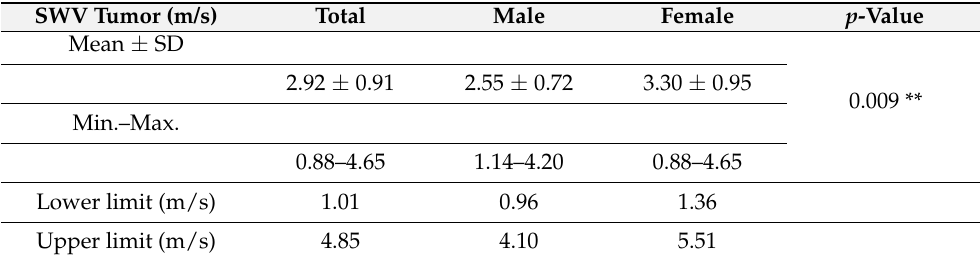
Table 5. SWV values in the PDA group.